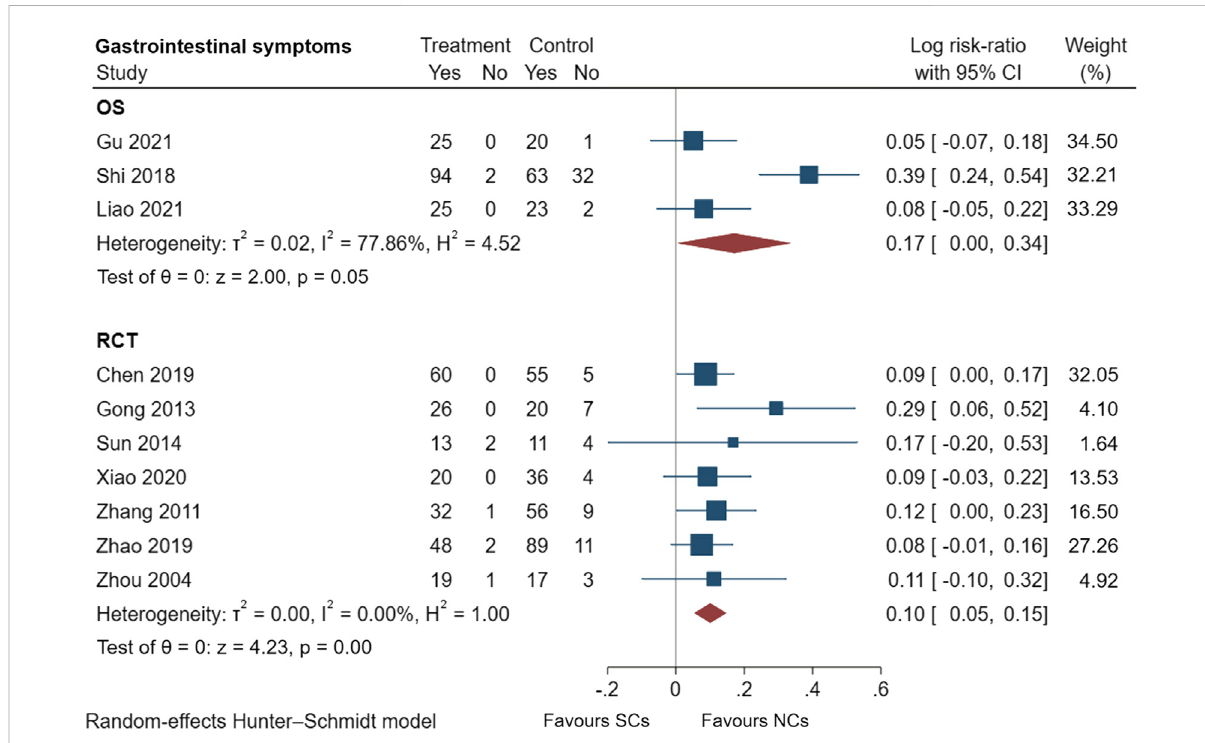
Gastrointestinal symptoms of SCs and NCs in observational studies and randomized controlled